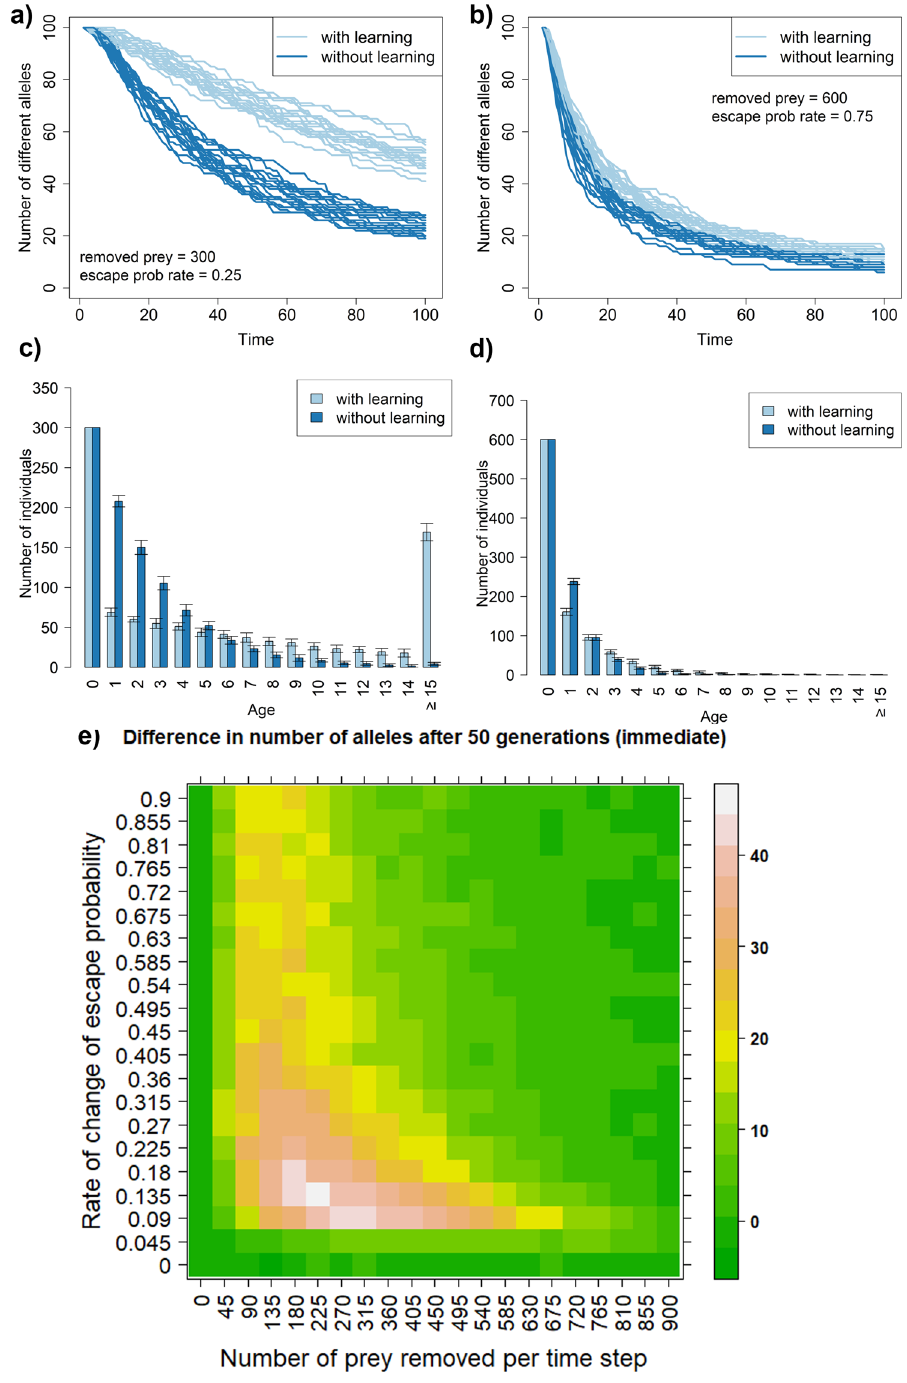
Figure 3. Immediate learning affects drift in a distinct way from stepwise learning. Temporal dynamics of the number of alleles present in populations of prey subject to predation. Panels ( a ) and ( b ) show 20 simulation runs for both learning and non-learning scenarios. Panels ( c ) shows age distributions for panel ( a ) and panel ( d ) show age distribution for panels ( b ). The values in the heatmap are averages from 10 simulation runs. In contrast to previous simulations prey learns instantly after unsuccessful predators` attacks. All prey populations consist of 1000 individuals at the beginning of each time step. Individuals killed by predators are replaced at the end of each step through a reproduction of surviving individuals ("Methods"). Predators kill the same number of individuals in both learning and non-learning scenarios to allow for a fair comparison. The upper bound on the probability of avoiding or escaping a predator attack is set to